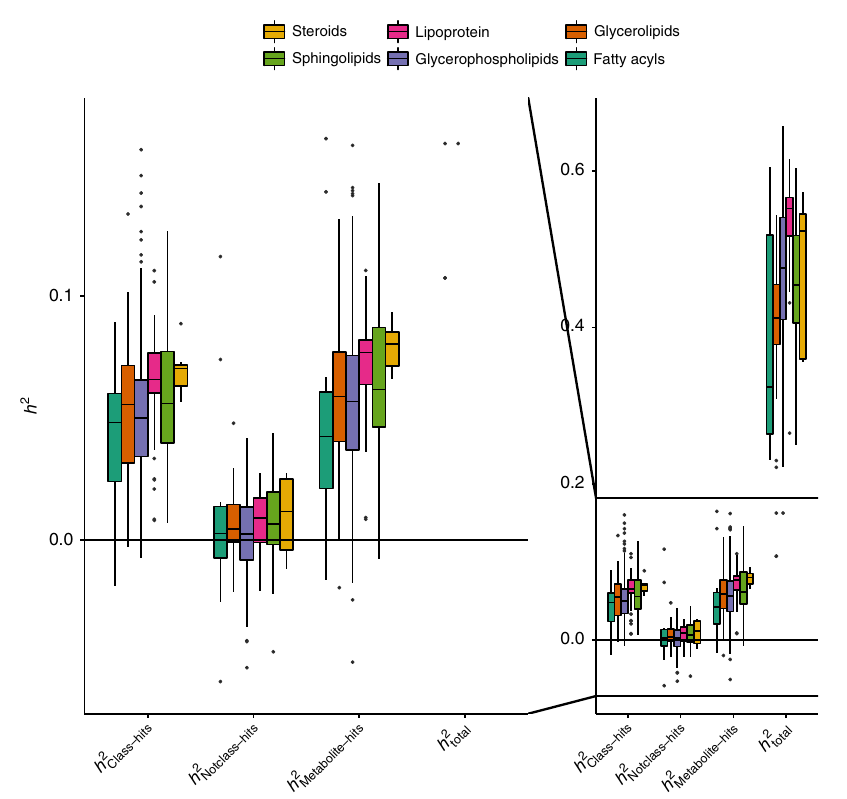
Fig. 3 Heritability of all 309 lipids by class. Box- and dotplots of the h 2 total , and h 2 Metabolite-hits for all 309 successfully analyzed lipids and lipid-like molecules across all metabolomics platforms by class. The left-hand side of the fi gure is a close-up of the − 0.06 to 0.17 part of the heritability range, focusing on the h 2 Class-hits and h 2 Notclass-hits estimates. The boxes denote the 25th and 75th percentile (bottom and top of box), and median value (horizontal band inside box). The whiskers indicate the values observed within up to 1.5 times the interquartile range above and below the box. The yellow, pink, orange, light green, purple, and dark green boxes denote the steroids, lipoprotein, glycerolipid, sphingolipid, glycerophospholipid, and fatty acyl classes, respectively. Supplementary Data 3 provides the estimates for each of the individual